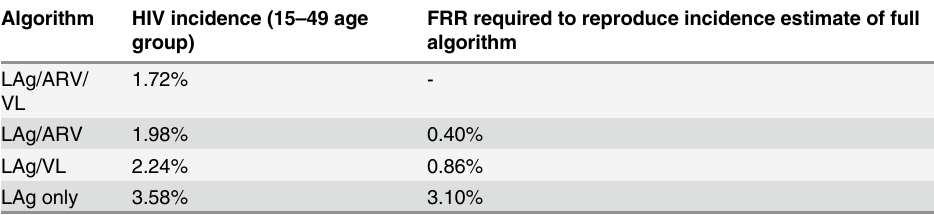
Table 3. Assay- based HIV incidence and FRR by testing component, South Africa 2012.